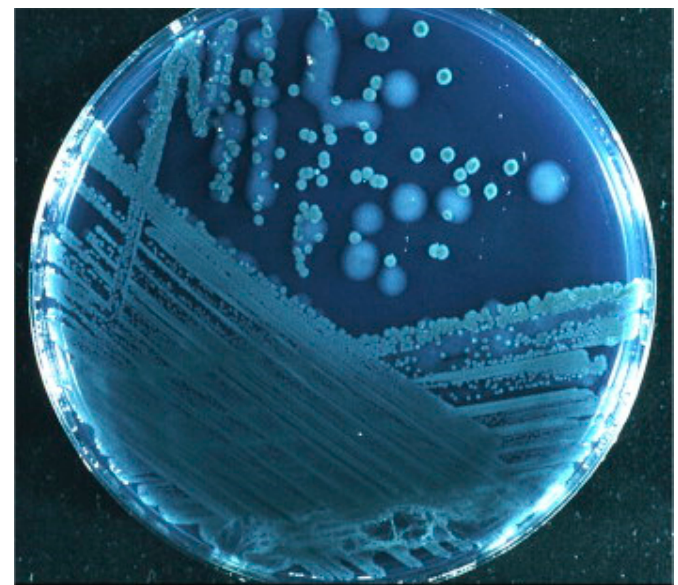
Figure 4. P. aeruginosa from sputum of a cystic fibrosis patient. Mucoid (large) and nonmucoid (small) colonies. The mucoid variant over-produces alginate, which is the matrix in the P. aeruginosa biofilm in the respiratory tract of cystic fibrosis patients. Mucoid colonies are only found in patients with chronic biofilm infection and alginate from mucoid colonies is therefore a biofilm-specific antigen. Høiby et al.